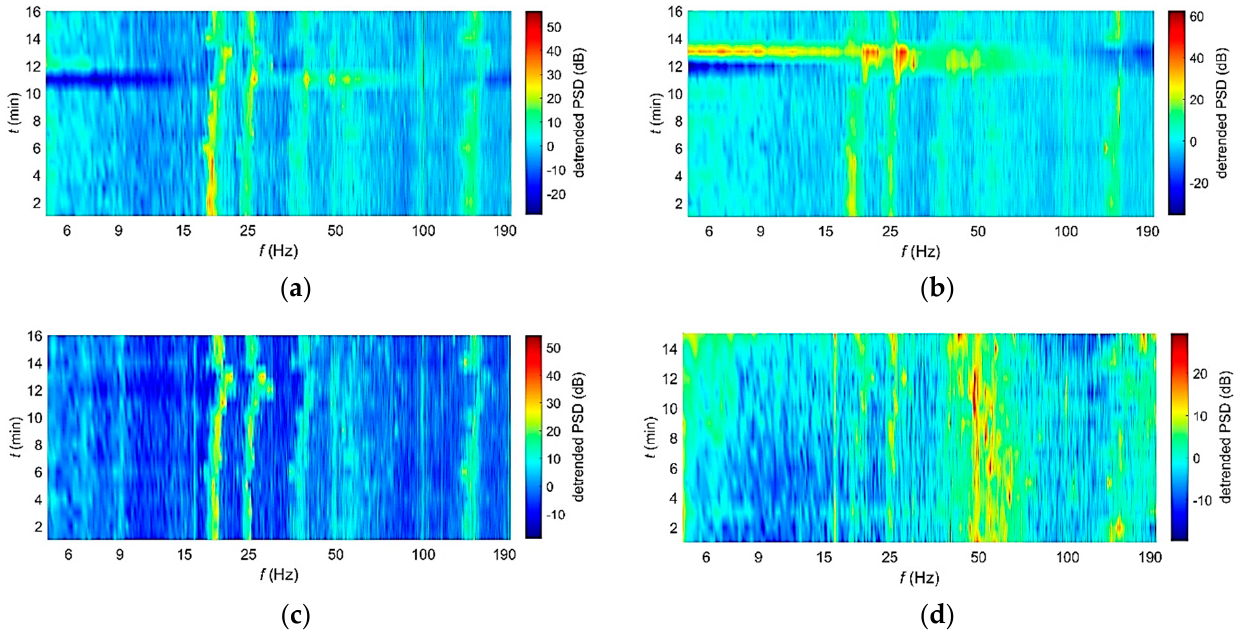
Figure 15. Example of two-dimensional PSD distributions, within a 15 min interval, gathered by ( a ) ST_1, ( b ) ST_2, ( c ) ST_3 and ( d ) PULSE